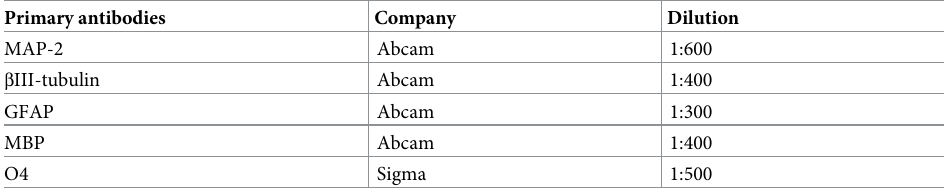
Table 1. Primary